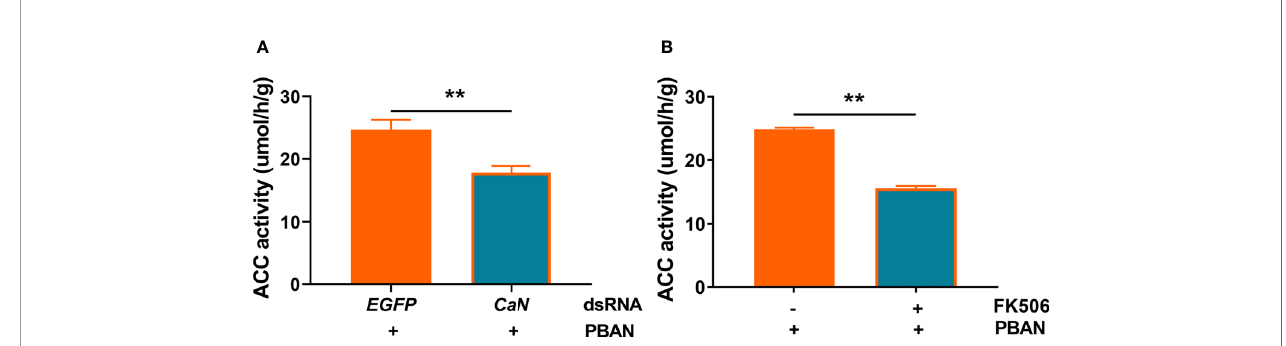
FIGURE 6 | CaN positively regulates ACC enzyme activity in O. furnacalis PGs. (A) Effect of ds CaN knockdown on ACC enzyme activity in O. furnacalis PGs. (B) Effect of the CaN inhibitor FK506 on ACC enzyme activity in O. furnacalis PGs. Data represent the mean ± SE (n = 3). Statistically signi fi cant differences were denoted with ** ( P < 0.01) as determined by Student ’ s